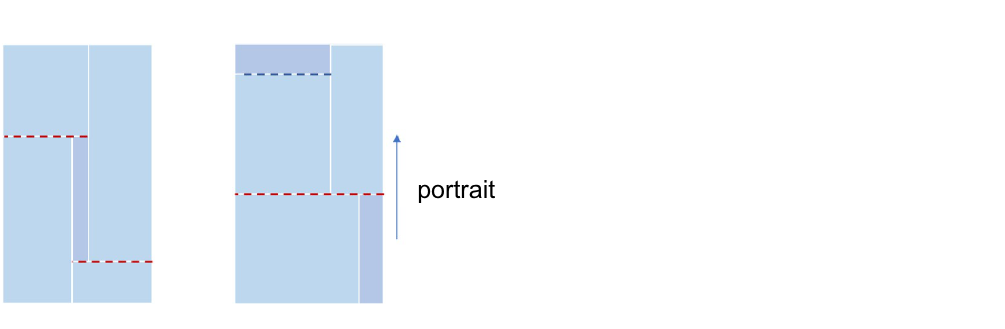
Figure 6. Transverse cutting